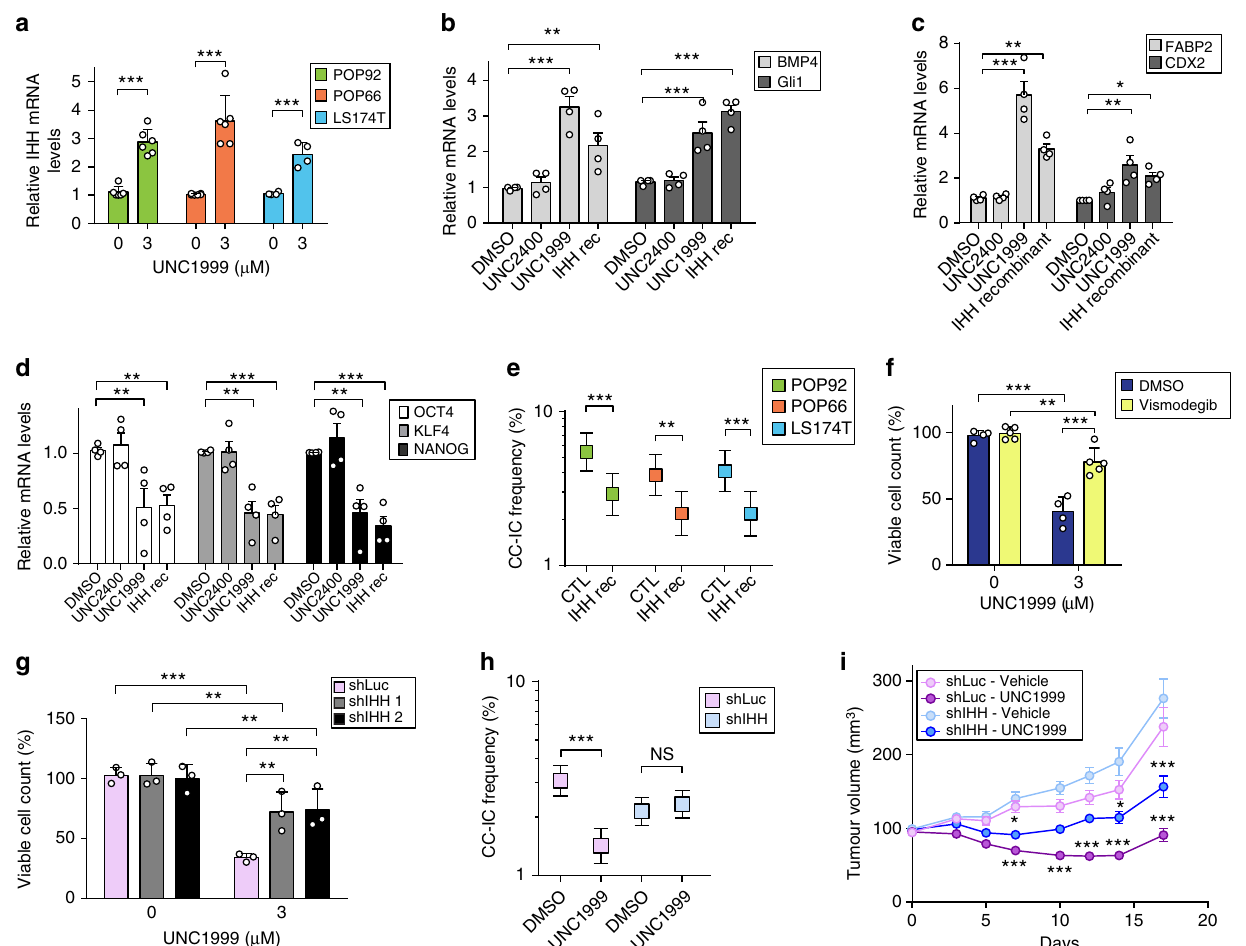
Fig. 5 EZH2 regulates CC-IC self-renewal through control of IHH expression. a RT-qPCR for IHH of UNC1999-treated cells. Cells were treated with UNC1999 at 3 µ M for 7 days and processed for RT-qPCR. Data shown are mean (POP66/POP92 n = 6, LS174T n = 4, ±SD, Student ’ s t test). b – d mRNA Levels on POP92 CC-ICs of Hedgehog target genes Gli1 and BMP4 ( b ), differentiation markers FABP2 and CDX2 ( c ), and the stem cell markers OCT4, KLF4, NANOG ( d ) monitored by RT-qPCR following UNC1999 or UNC2400 treatment (3 µ M), or recombinant IHH (5 µ g/mL) for 7 days. Data shown are mean ( n = 4, ±SEM, one-way ANOVA). e LDA on POP92, POP66 and LS174T cells pretreated with recombinant IHH (5 µ g/mL) for 10 days. Data shown are n = 3 and represent mean ±95% con fi dence interval, frequency and probability were computed using ELDA software. f POP92 spheroids treated with DMSO or UNC1999 (3 µ M) in the presence of SMO inhibitor Vismodegib (10 µ M) or DMSO control for 7 days. Viable cell count was measured and samples normalised to their respective control. Data shown are mean ( n = 5, ±SD, two-way ANOVA). g IHH knocked down in POP92 using two different hairpins, and sensitivity towards UNC1999 was assessed using viable cell count via fl ow cytometry. Data are normalised to DMSO control performed in n = 3, ±SD, two-way ANOVA. h POP92 with IHH knockdown were treated with UNC1999 (3 μ M) or DMSO control for 7 days prior to seeding in LDA. Data shown are n = 2 and represented as mean ±95% con fi dence interval. Frequency and statistics were computed using ELDA software. i POP92 spheroids infected with either shRNA against Luciferase (shLuc) or shRNA targeting IHH (shIHH) were injected into mice and treated with vehicle or UNC1999 (300mg/kg). Tumour volume was measured over time. Data are n = 20 tumours (shLuc ± UNC1999), n = 19 tumours (shIHH± UNC1999), ± SEM, two-way ANOVA with Tukey multiple test correction. * P <0.05, ** P